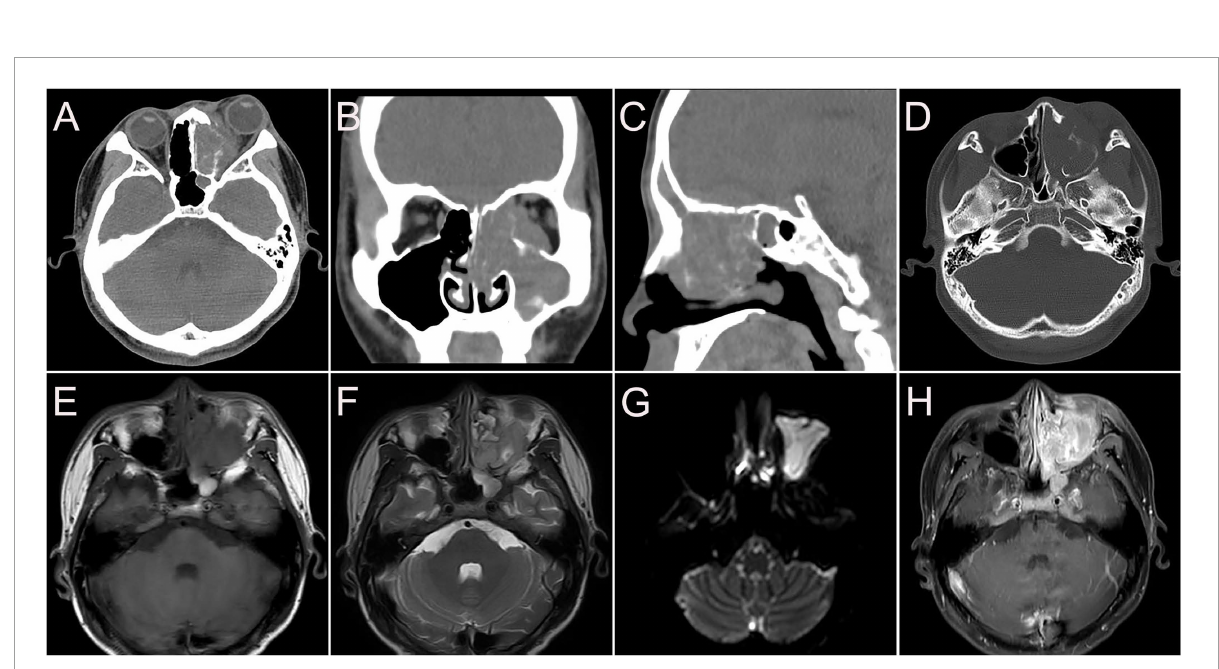
FIGURE5 CT and MR images of nasal sinus ARMS in case 2. (A–D) CT images ( A . transverse, B . coronal, C . sagittal, and D . bone window) showed soft tissue mass in the left nasal cavity, maxillary sinus, ethmoidal sinus, sphenoidal sinus, frontal sinus, and nasal cavity with local protrusion into the left orbit, interrupted bony continuity of the medial wall of the left maxillary sinus and lateral wall of the septal sinus. (E) The lesions showed slightly low signal T1WI. (F) High signal on T2WI. (G) High signal on DWI. (H) Significant heterogenous enhancement on enhanced